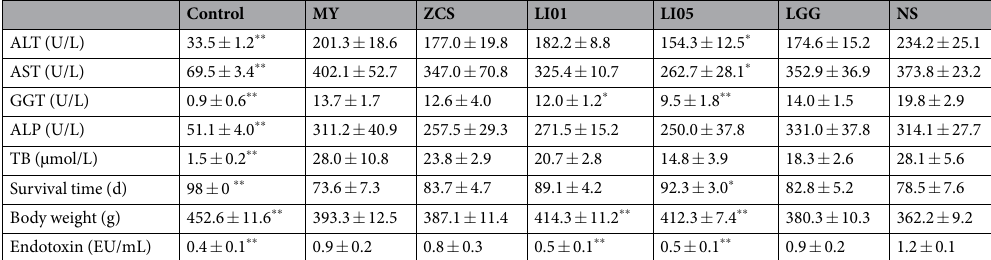
Table 1. Liver enzymes, bilirubin levels, survival time, body weight and endotoxin in the experimental groups. Values are expressed as the mean ± SEM. * P < 0.05, ** P < 0.01 compared with the NS